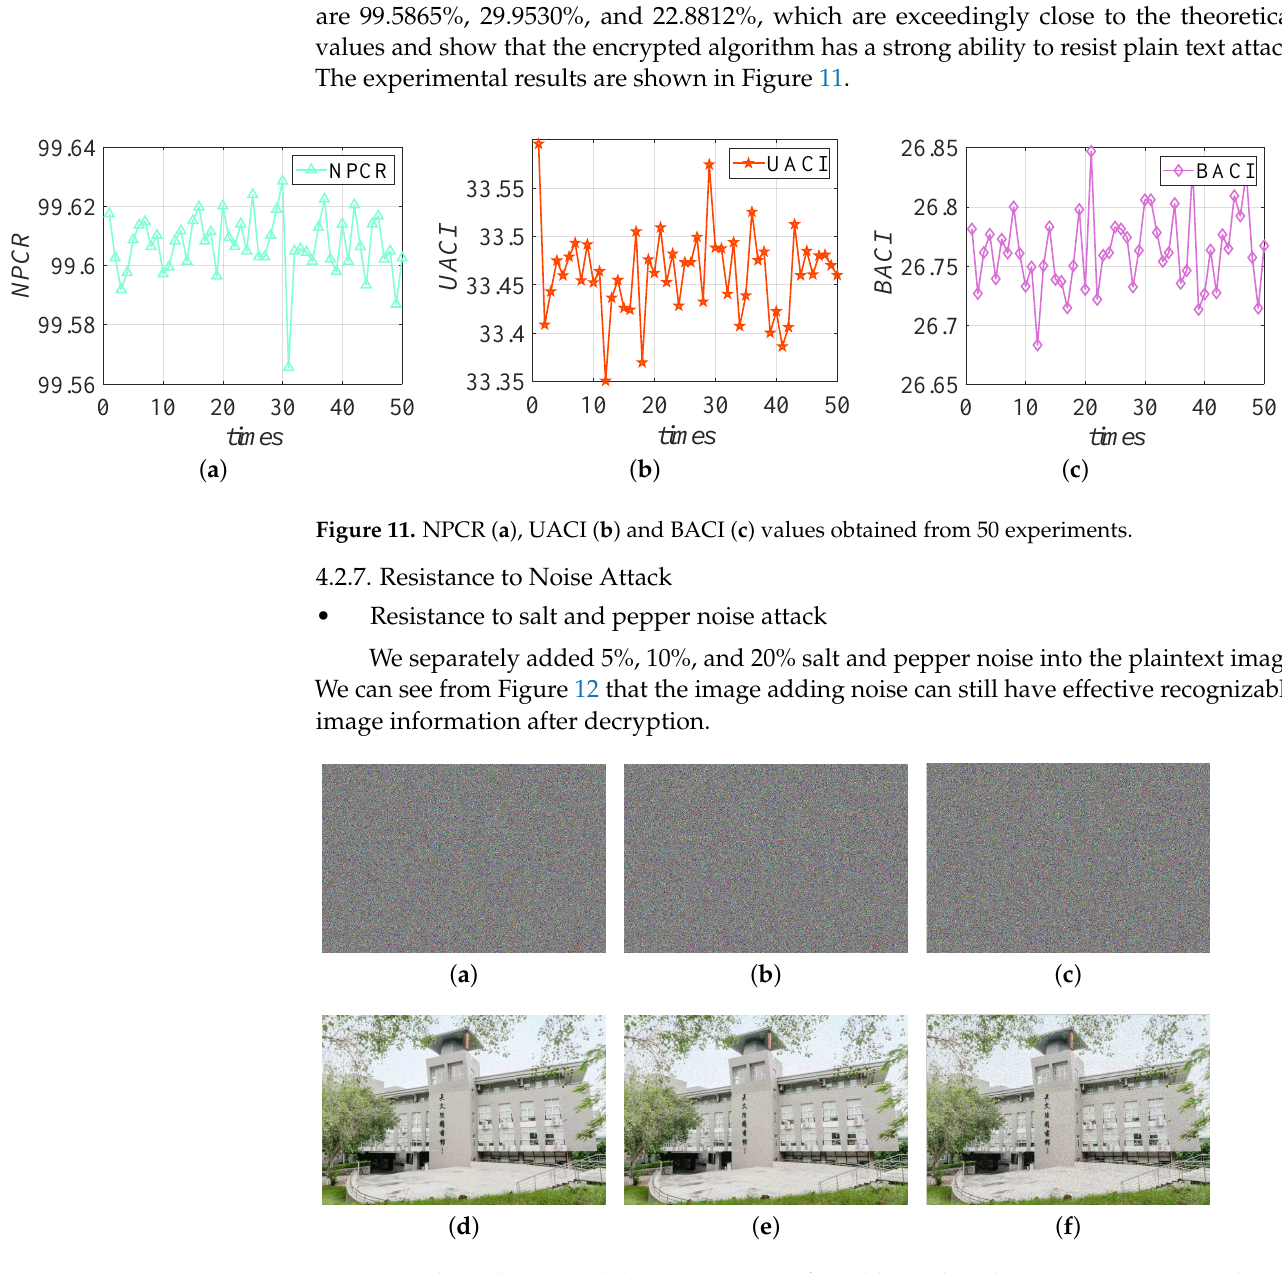
Figure 12. The ciphertext and decryption image after adding salt-and-pepper noise: ( a ) 5% salt-and- pepper noise ciphertext images; ( b ) 10% salt-and-pepper noise ciphertext images; ( c ) 20% salt-and- pepper noise ciphertext images; ( d ) 5% salt-and-pepper noise decryption images; ( e ) 10%